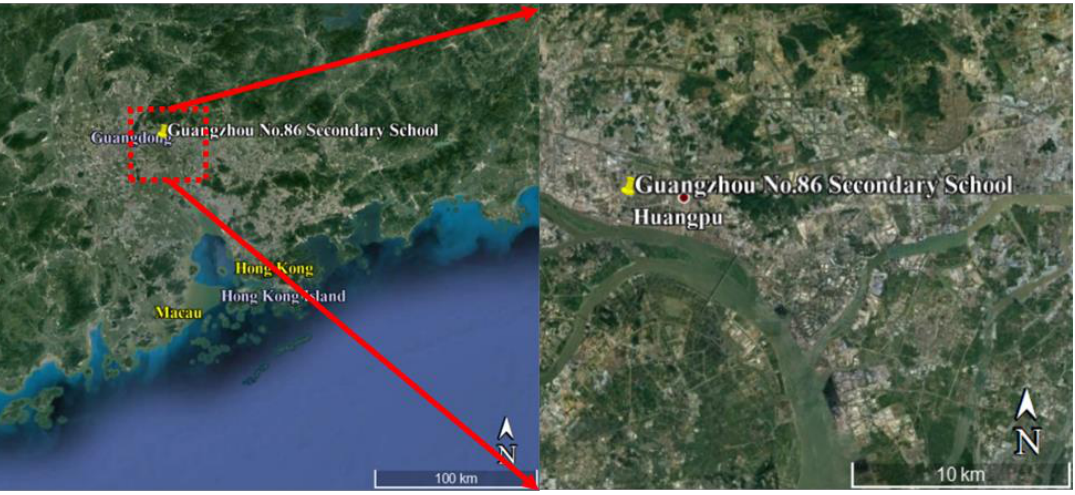
Figure 1. Location of the sampling site. The background figure is taken from Google Maps.